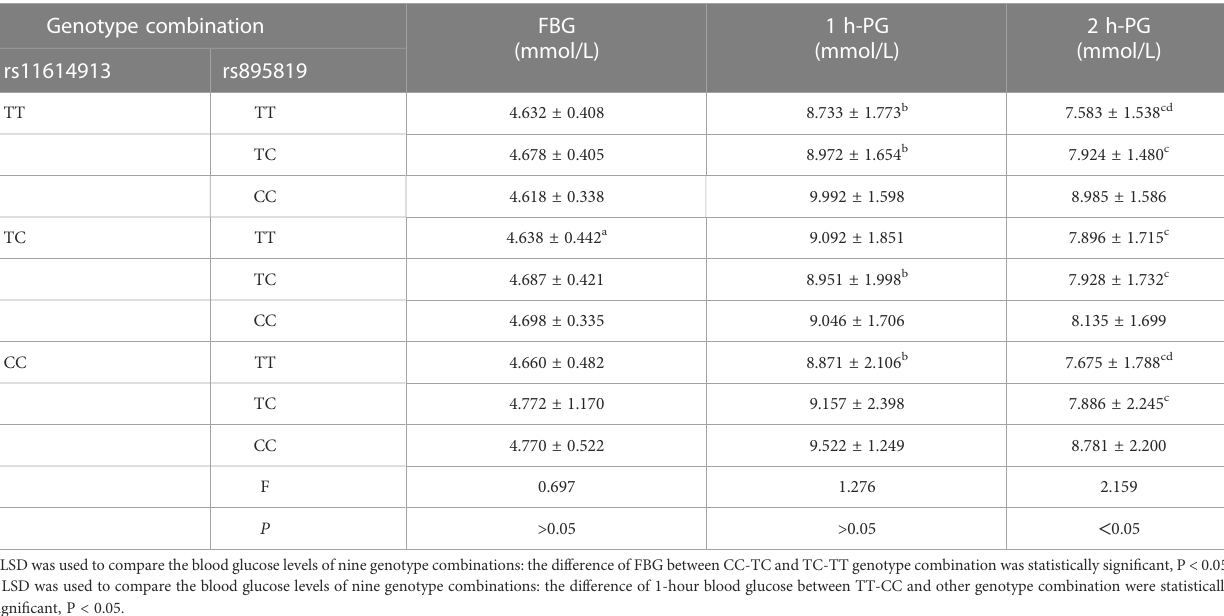
TABLE 6 Relationship between polymorphisms combined genotype and blood glucose levels.